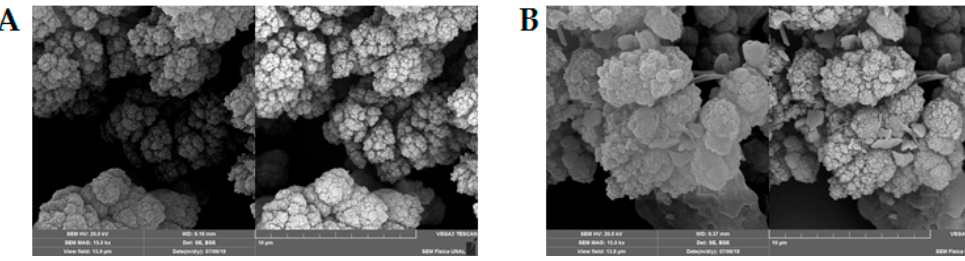
Figure 2. Comparative SEM of poly(BMA– co –EDMA– co –GMA) unmodified ( A ) and functionalized with aminomethylated-calix[4]resorcinarene 5 ( B ).